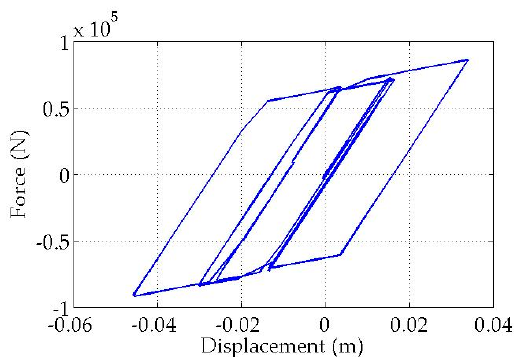
Figure 5. Hysteresis of the mid-pier LRB under North Palm Springs Earthquake.